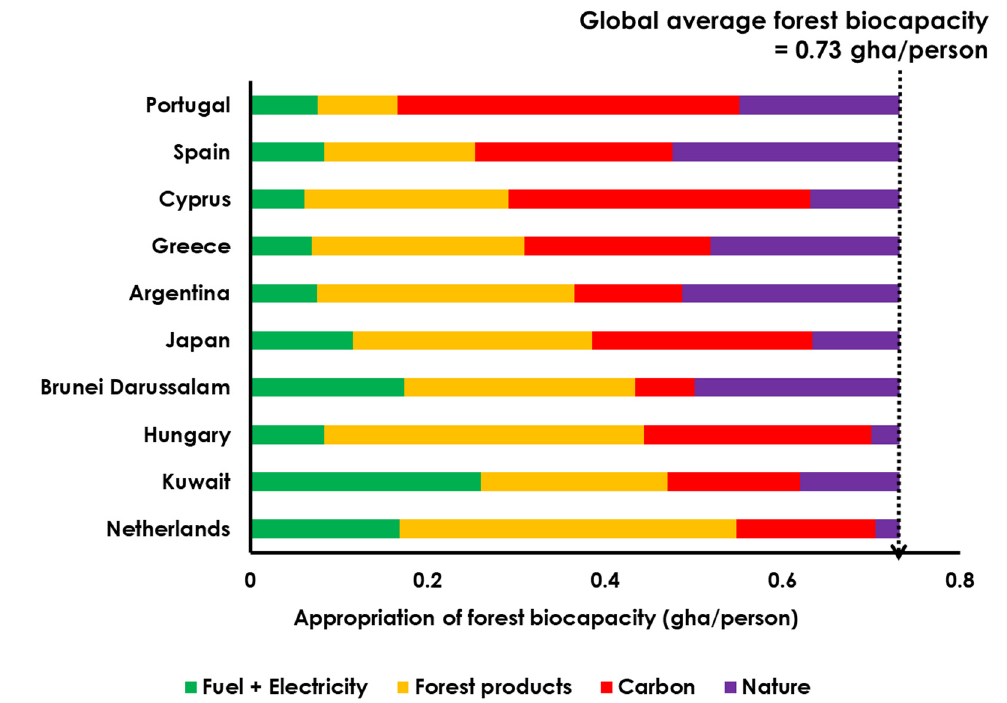
Figure 9. Appropriation of global average forest biocapacity according to different consumption types, for ten countries with Human Development Index (HDI) > 0.8 (see Figure 8). The ‘Fuel + Electricity’ area is from Scenario 3 (Electrification + Synfuel).